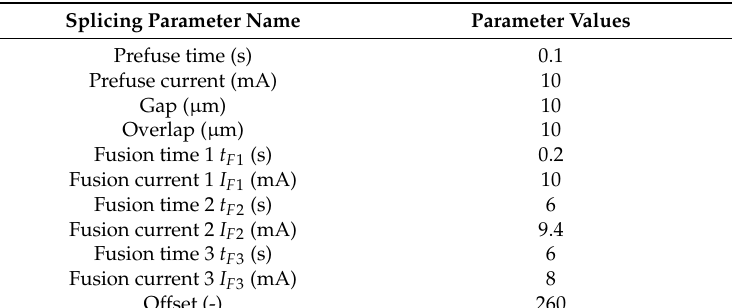
(HC-800-02, NKT Photonics, Birkerød, Denmark) and solid-core, multimode, type OM2 fibers. process quicker than in the case of standard fiber tapering.